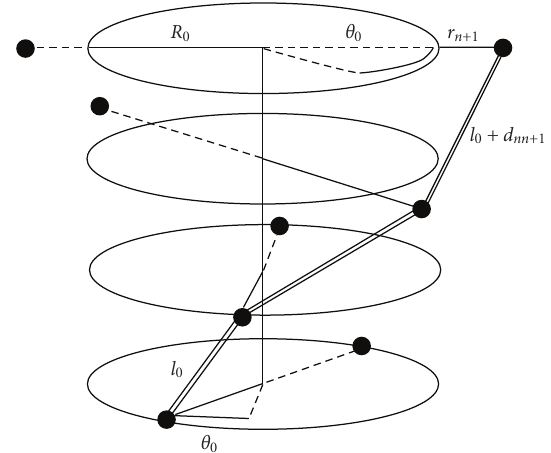
Figure 3: Sketch of the structure of the DNA model. The bases are represented by bullets, and the geometrical parameters R 0 , (cid:6) 0 , θ 0 , r n +1 , and d nn +1 are indicated.